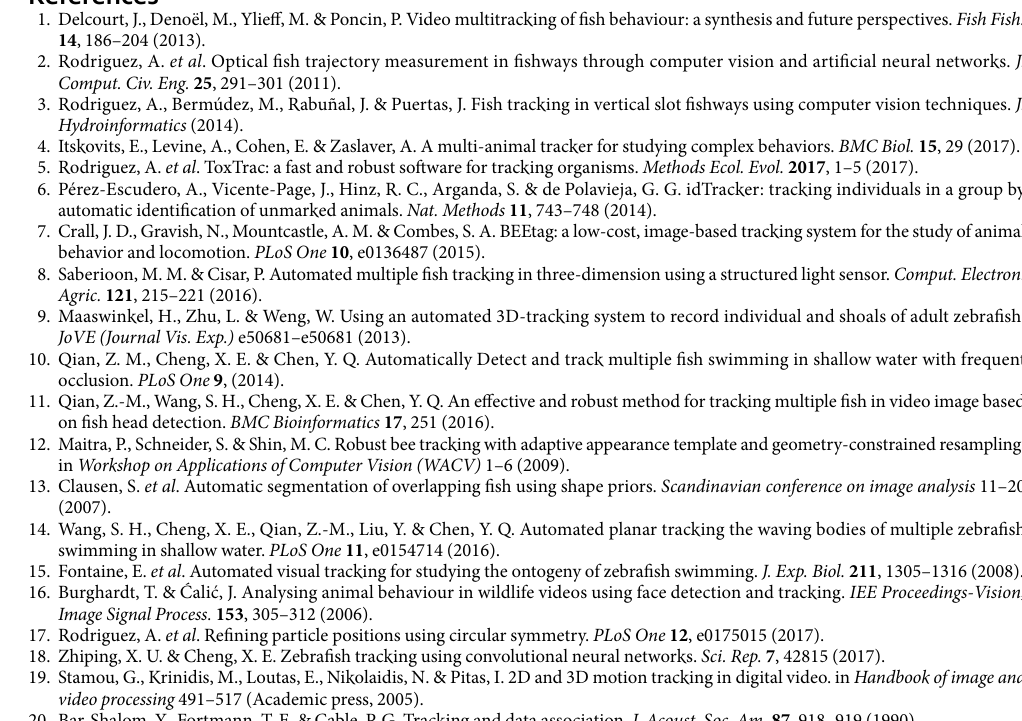
download at https://toxtrac.sourceforge.io and to reproduce the results in this work follow the steps provided in the Reproducing the results section in the supplementary materials. If you have problems accessing the files please contact the corresponding author.